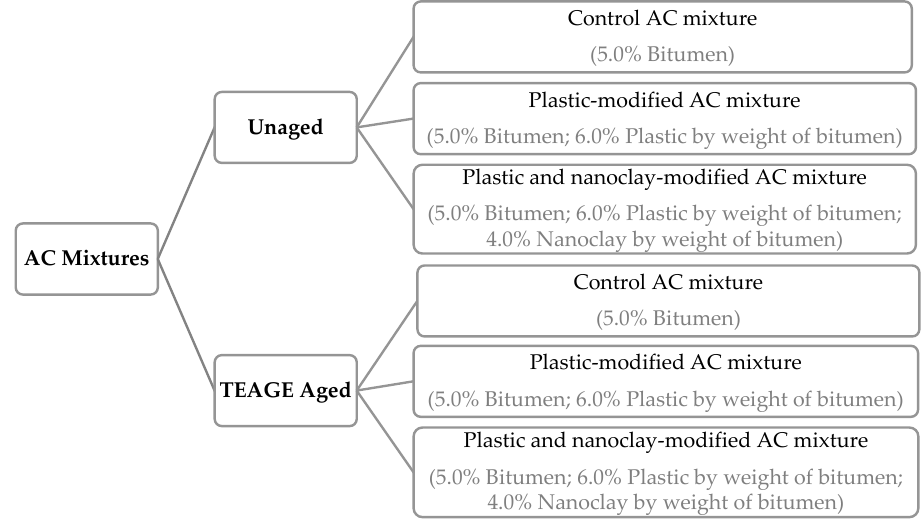
Figure 3. Tested asphalt concrete (AC) mixtures.